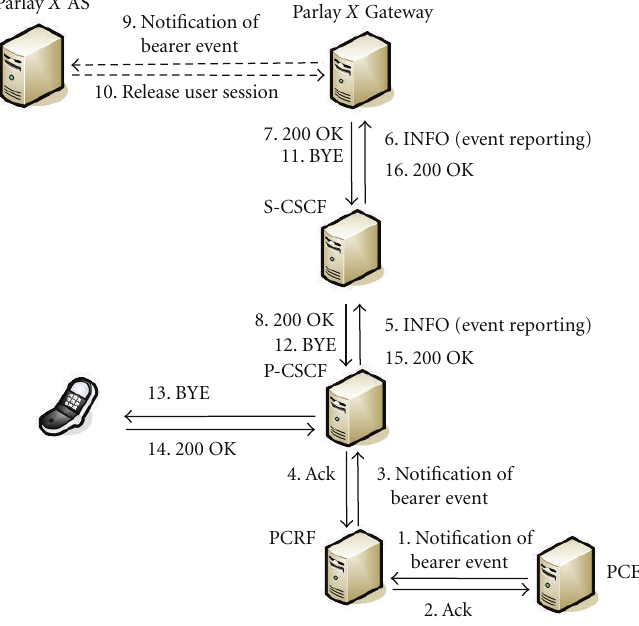
Figure 3: Notification of QoS resource release and application-initiated session release.